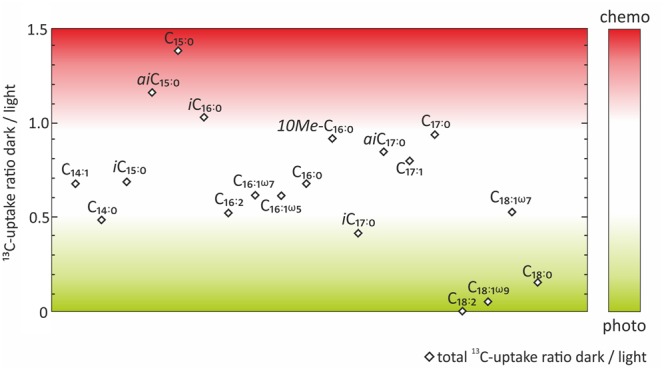
Ratios between dark and light incubations of the absolute 13C-uptake into fatty acids. Color code indicates which fatty acids were more likely to be indicative of chemoautotrophy (red) or photoautotrophy (green).